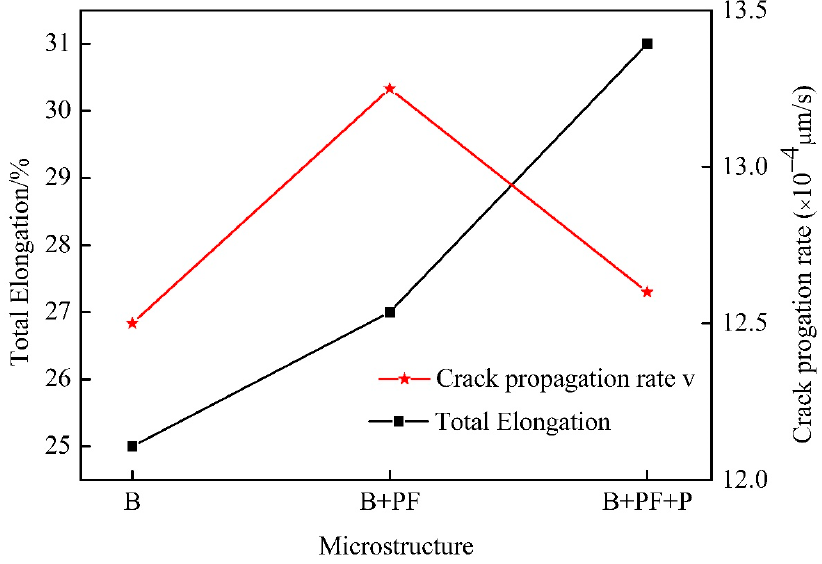
Figure 9. Variations in elongation versus fracture and crack propagation rate for different samples. The fracture morphologies parallel to the tensile direction are shown in Figure 10. The main crack propagation paths of all the samples are marked with red lines. The more tortuous the crack propagation paths, the higher the crack propagation work required during the propagation process [29]. As shown in Figure 10c, the more tortuous crack propagation paths of the triple-phase sample indicated that it can withstand large strain to fracture, which is consistent with its high elongation. The density of micro-voids de- creased significantly in the dual-phase and triple-phase samples. The microcracks shown in Figure 10b,c, are caused by Mg/Al oxide inclusions during the smelting process (EDS results of pint A of Figure 10d). Ohata et al. found that the voids originating from large inclusions cannot cause ductile damage in the dual-phase steel [30]. Instead, it was caused by the formation of a particular number of voids near the boundaries of the hard-soft phase. As shown in Figure 10e,f, the location of the micro-void in bainite was mainly lo- cated at the BF/BF, BF/carbides boundaries. However, the ferrite and pearlite in the triple- phase sample can elongate along the tensile direction (Figure 10g,h), and the micro-voids mainly formed at the boundaries of the ferrite and M/A island, and were more distributed.